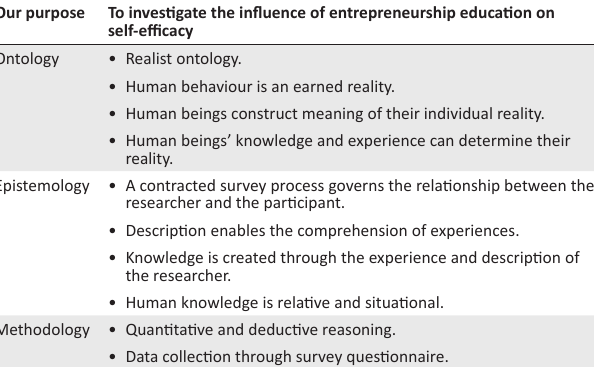
TABLE 1: Research paradigm.